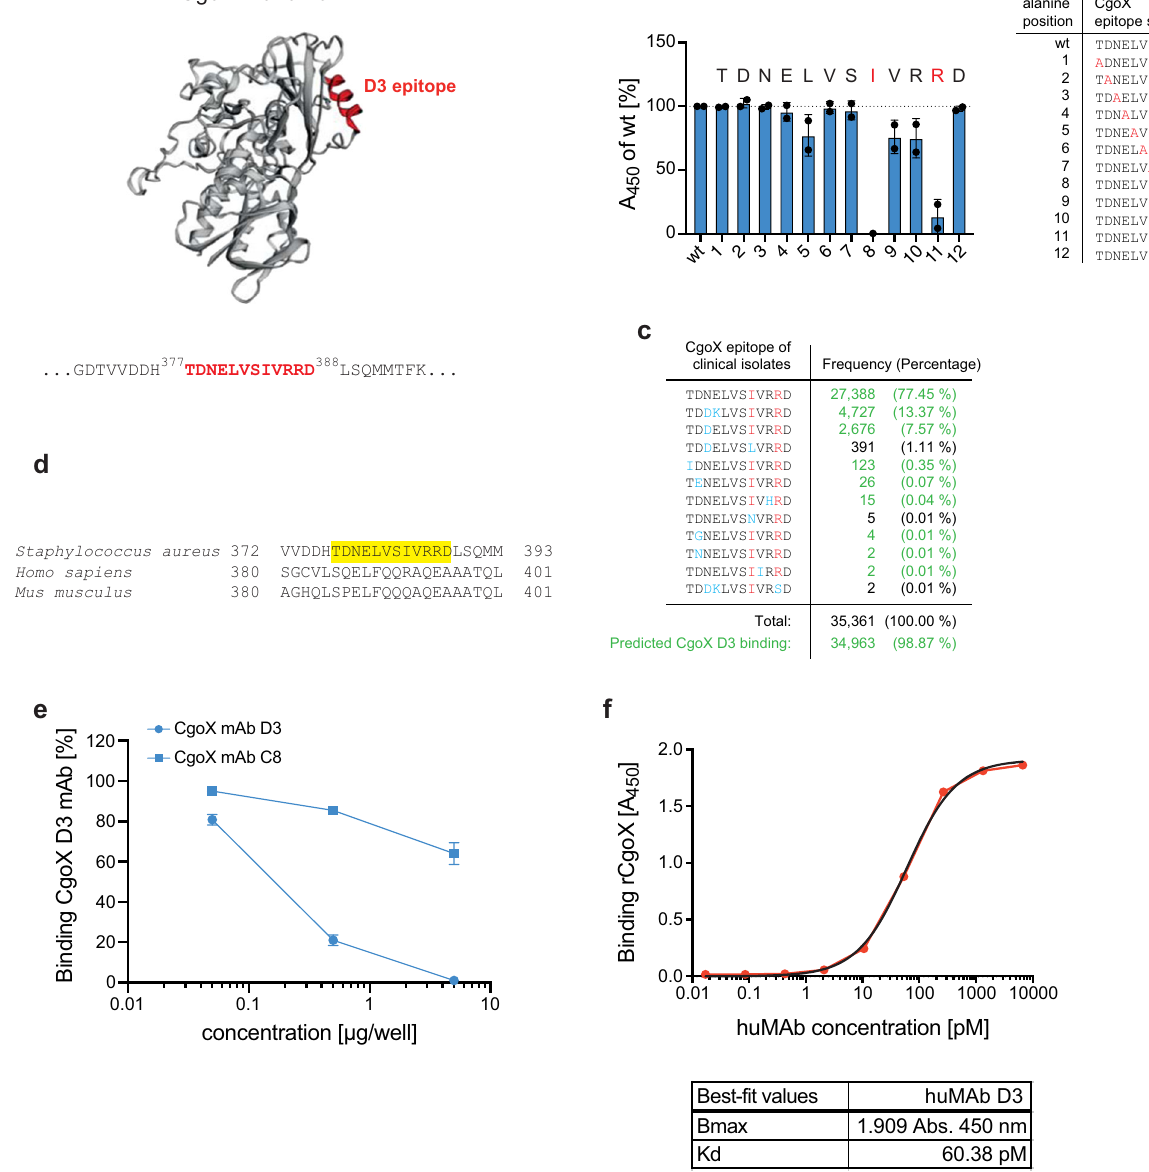
Fig. 3 Characterisation of anti-CgoX mAb D3 epitope. a S. aureus CgoX structure was modulated from B. subtillis (3I6D.pdb). The linear epitope of mAb D3 (red) was identi fi ed by microarray technology using overlapping 13mer CgoX peptides (Supplementary Fig. 3). Protein structure was visualised by EzMol2.1. b Alanine scan of epitope peptides for binding analysis of anti-CgoX mAb D3. Single amino acid positions of the D3 epitope were consecutively replaced by alanine (red in right panel). Immobilised peptides were stained by anti-CgoX mAb D3 detected with anti-mIgG-HRP. Data are presented as mean ± s.d. ( n = 2 technical replicates). c Allele frequencies of anti-CgoX mAb D3 epitope. Genome sequences of S. aureus clinical isolates were analysed for epitope aa sequence using the RidomSeqsphere core genome multi locus sequence typing (cgMLST) database. Amino acids interacting with paratope of anti-CgoX mAb D3 according to alanine scan are marked in red. Amino acid differences from identi fi ed epitope peptide sequence are marked in blue. Frequencies of alleles with non-restricted binding of anti-CgoX mAb D3 are marked in green. d Uniqueness of the CgoX D3 epitope in S. aureus . Sequence alignment of CgoX from S. aureus with PPOX from H. sapiens and M. musculus . CgoX D3 epitope is depicted in yellow. e Competition analysis of CgoX mAb. Binding of DyLight-649-conjugated anti-CgoX mAb D3 to rCgoX was competed for with different concentrations of unconjugated, indicated mAbs and analysed by ELISA. Binding was determined by fl uorescence measurement (Ex 646/Em 674). Data are presented as mean ± s.d. ( n = 2). f Saturation binding curve was generated by plotting absorbance signals (OD 450nm ) of increasing amounts of anti-CgoX huMAb D3 to rCgoX coated on ELISA MaxiSorp plate using the GraphPadPrism 8.4 software. Kd was calculated by non-linear fi tting and the equation for one-site binding model [Y = Bmax*X/(Kd +